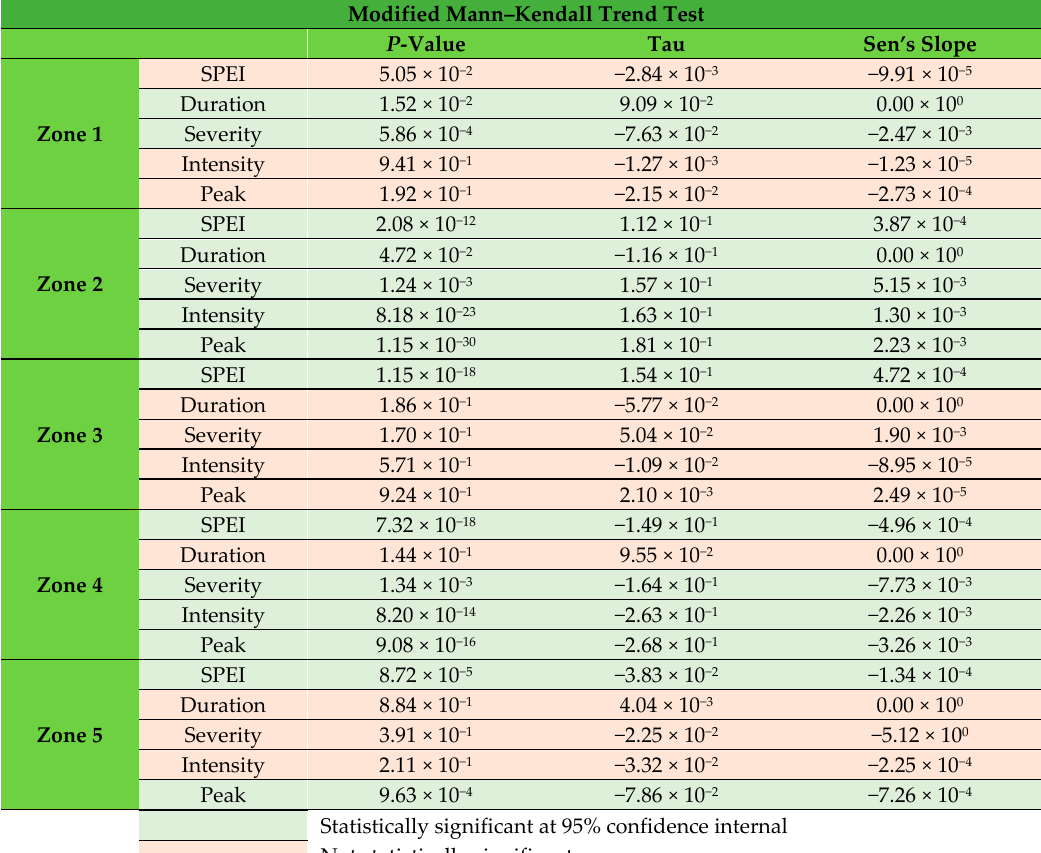
Table 1. Modified Mann–Kendall trend test results.